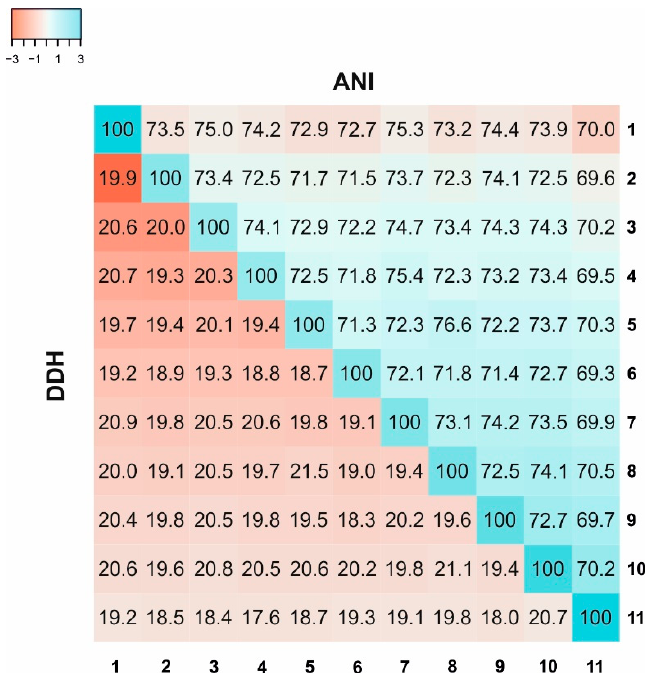
Figure 4. Average Nucleotide Identity (ANI) and in silico DNA–DNA hybridization (DDH) percentages between strain F16-60 T and other species and genera from the order Halobacteriales . Average Nucleotide Identity (ANI) and in silico DNA–DNA hybridization (DDH) are represented by heat maps, where similarity percentages are represented by the color key histograms on the upper panel. Strains: 1. Halosimplex carlsbadense 2-9-1 T (GCF_000337455); 2. Halorhabdus utahensis DSM 12940 T (GCF_000023945); 3. Halorientalis regularis IBRC-M 10760 T (GCF_900102305); 4. Haloarcula vallismortis ATCC 29715 T (GCF_000337775); 5. Natronomonas pharaonis DSM 2160 T (GCF_000026045); 6. Halobacterium salinarum NRC-1 (GCF_000006805); 7. Halomicrobium mukohatei DSM 12286 T (GCF_000023965); 8. Natronomonas moolapensis 8.8.11 T (GCF_000591055); 9. Halapricum salinum CBA 1105 T (GCF_000755225); 10. Strain F16-60 T (QMDX00000000); 11. Halomarina oriensis SPP-AMP-1 T (GCA_003862495). Table 1. Average Amino Acid Identity (AAI) percentages, highlighted in bold, between strain F16-60 T and other species and genera from the order Halobacteriales . AAI